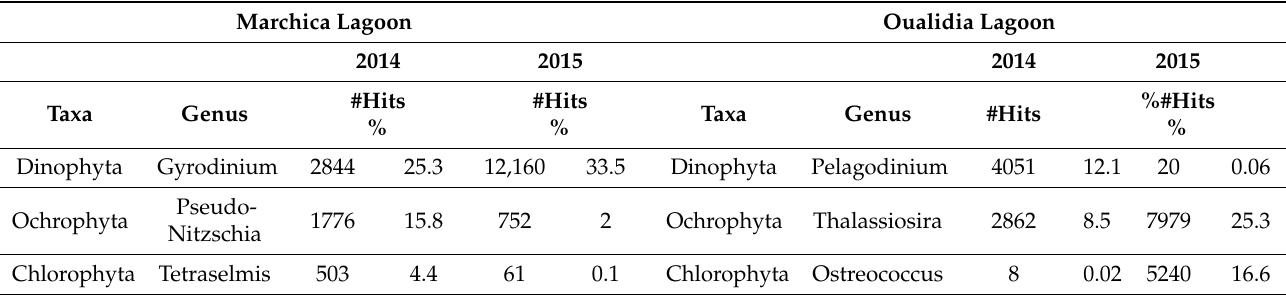
Table 8. 18S metagenomic rRNA from selected high abundant sequences assigned to a genus for both sampling campaigns 2014 and 2015 in both